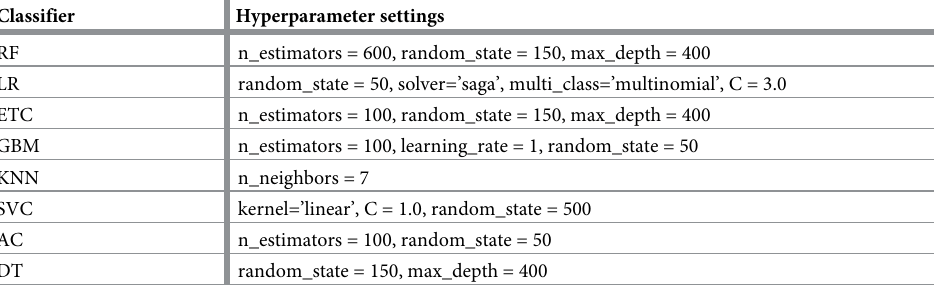
Table 3. Hyperparameter settings of machine learning sentiment